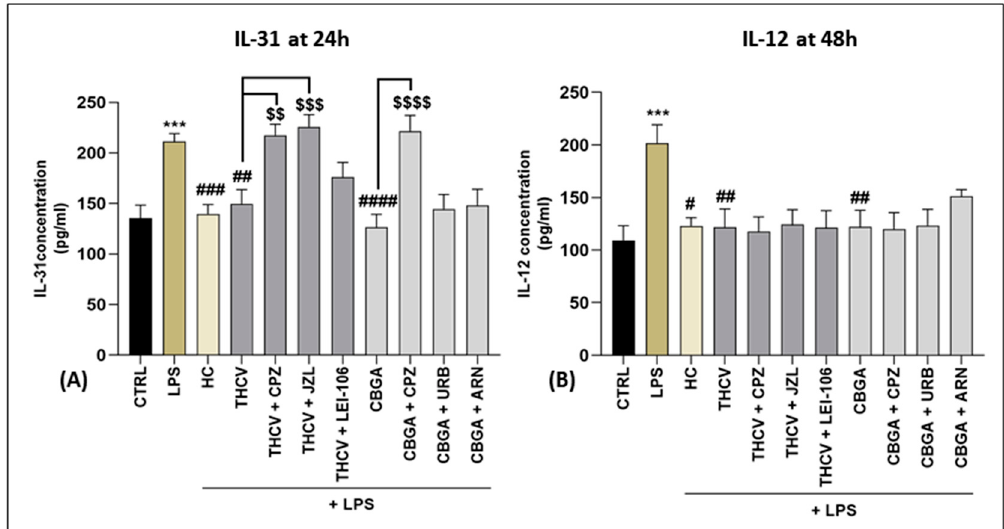
Figure 3. Release of IL ‐ 31 at 24 h and IL ‐ 12 at 48 h into HaCaT cells medium. ( A ) IL ‐ 31 and ( B ) IL ‐ 12 expression (pg/mL) in HaCaT cells following 24 h and 48 h treatment with LPS at 5 μ g/mL in the presence of HC at 10 μ M, including each pCB (THCV at 9.3 μ M and CBGA at 13.0 μ M) or selected